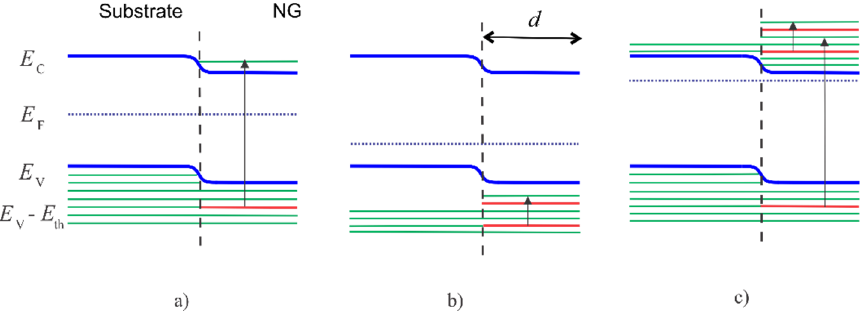
Figure 2. Basic energy-band diagrams of an NG layer fabricated on the surface of ( a ) an i-type semiconductor, ( b ) a p-type semiconductor, and ( c ) an n-type semiconductor. The green lines indicate the levels occupied by electrons and the red lines indicate the levels forbidden by the NG. For simplicity, the band gap is scaled down and the energy levels are shown to be equidistant.